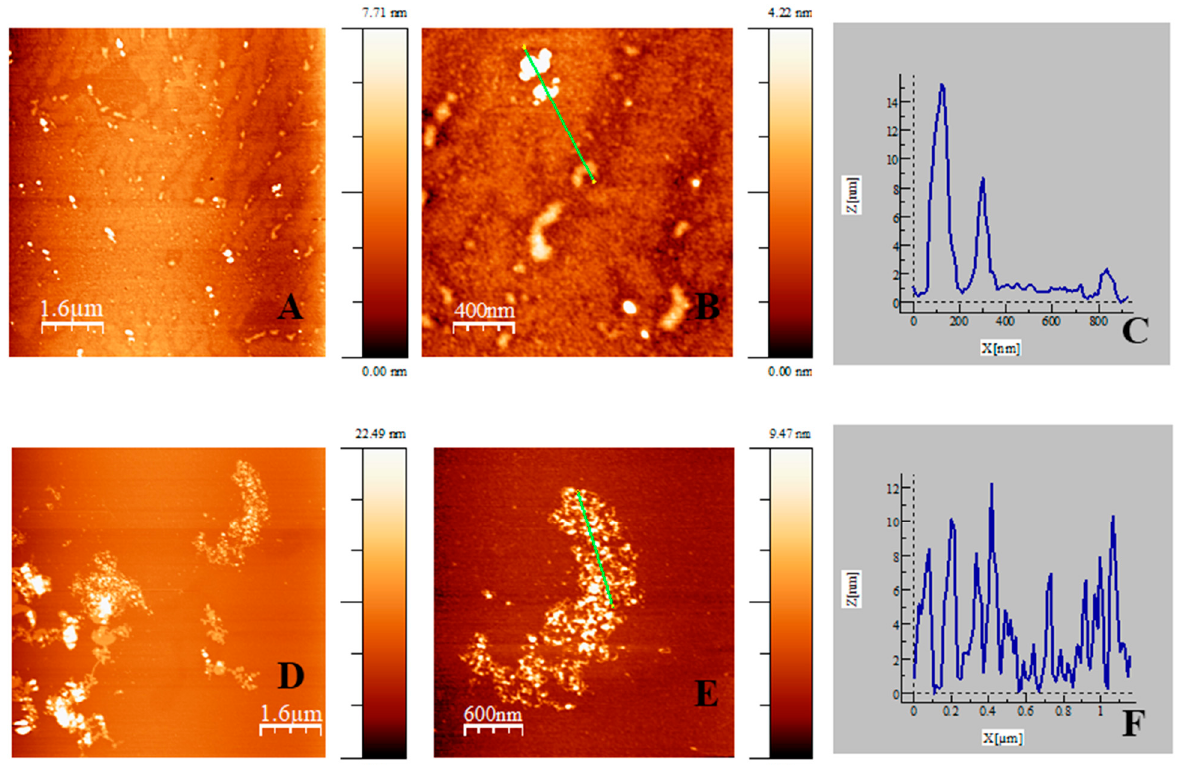
Figure 8. AFM topography images of Au@16-3-16/Lysozyme/SDS and Au@16-6-16/Lysozyme/SDS systems adsorbed on APTES-modified mica surface under Au@16-s-16 disaggregation condition, and the corresponding size distribution of Au@16-s-16 nanoparticles along the selected lines. Reactant concentrations used were: C Au@16-3-16 = 1.74 × 10 − 8 M, C Au@16-6-16 = 1.38 × 10 − 8 M, C SDS = 30 µM, and C Lysozyme = 1.0 × 10 − 5 M. ( A – C ) Au@16-3-16/SDS/Lysozyme system. ( D – F ) Au@16-6- 16/SDS/Lysozyme system (addition method A). Table 4. Values of the hydrodynamic diameters of different Au@16-s-16 nanosystems in the presence of fixed C SDS = 5.0 × 10 − 5 M concentration and